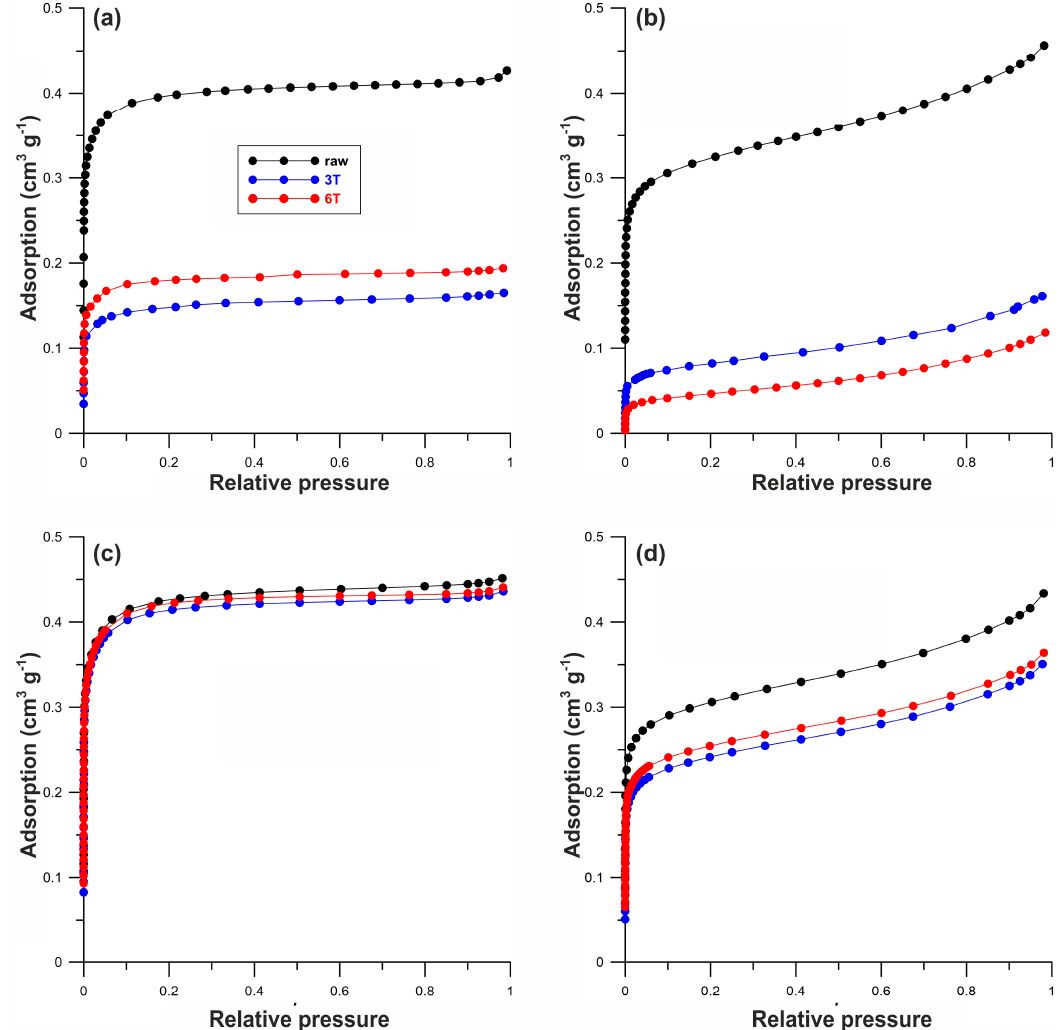
Figure 1. Nitrogen adsorption isotherms of pristine carbon, oxidized, and hybrid materials for ( a )